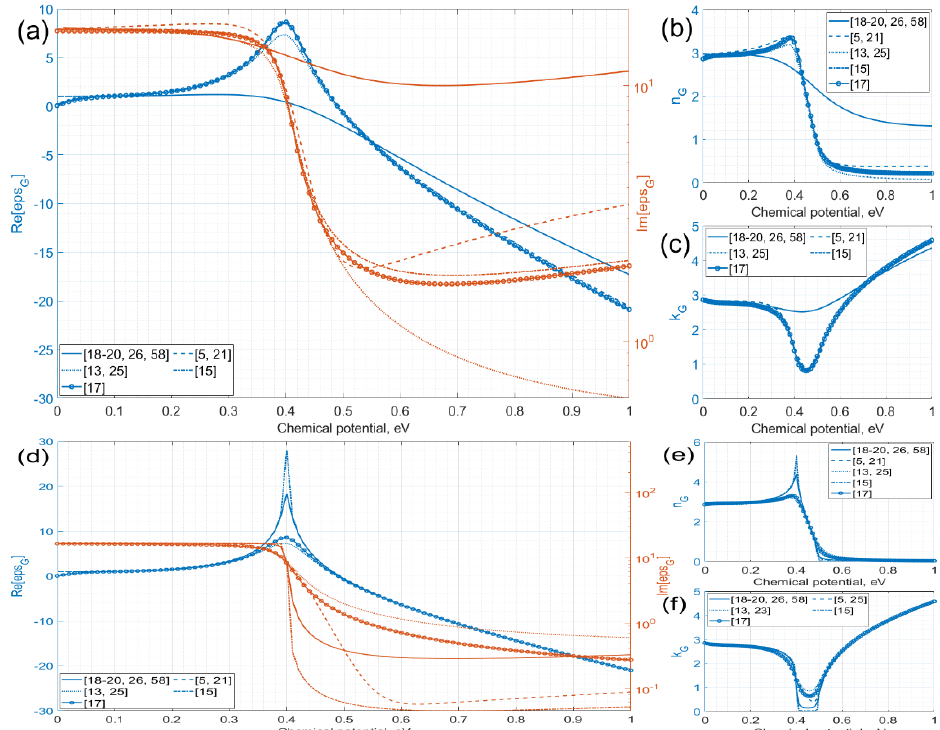
Figure 5. ( a ) Real (blue curves) and imaginary (red curves) parts of the permittivity, ( b ) refractive index and ( c ) extinction coefficient as a function of the chemical potential from various publications, when λ = 1.55 µ m, t G = 0.34 nm, µ c = 0 ÷ 1 eV, Γ = 8e13 s − 1 and T = 300 K. ( d ) Real and imaginary parts of the permittivity, ( e ) refractive index and ( f ) extinction coefficient as a function of the chemical potential from various publications, when λ = 1.55 µ m, t G = 0.34 nm, µ c = 0 ÷ 1 eV, Γ = 2e12 s − 1 , T = 300